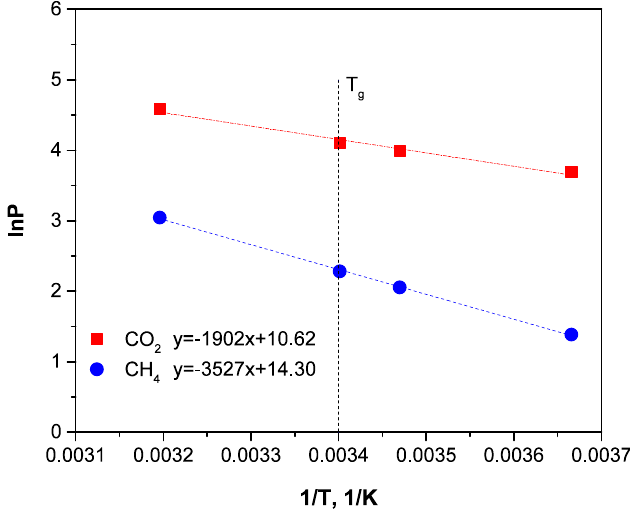
Figure 6. Temperature-dependent permeability coefficient of the triaxial braided hose membrane module for CO 2 and CH 4 in the mixture (50/50%vol.).